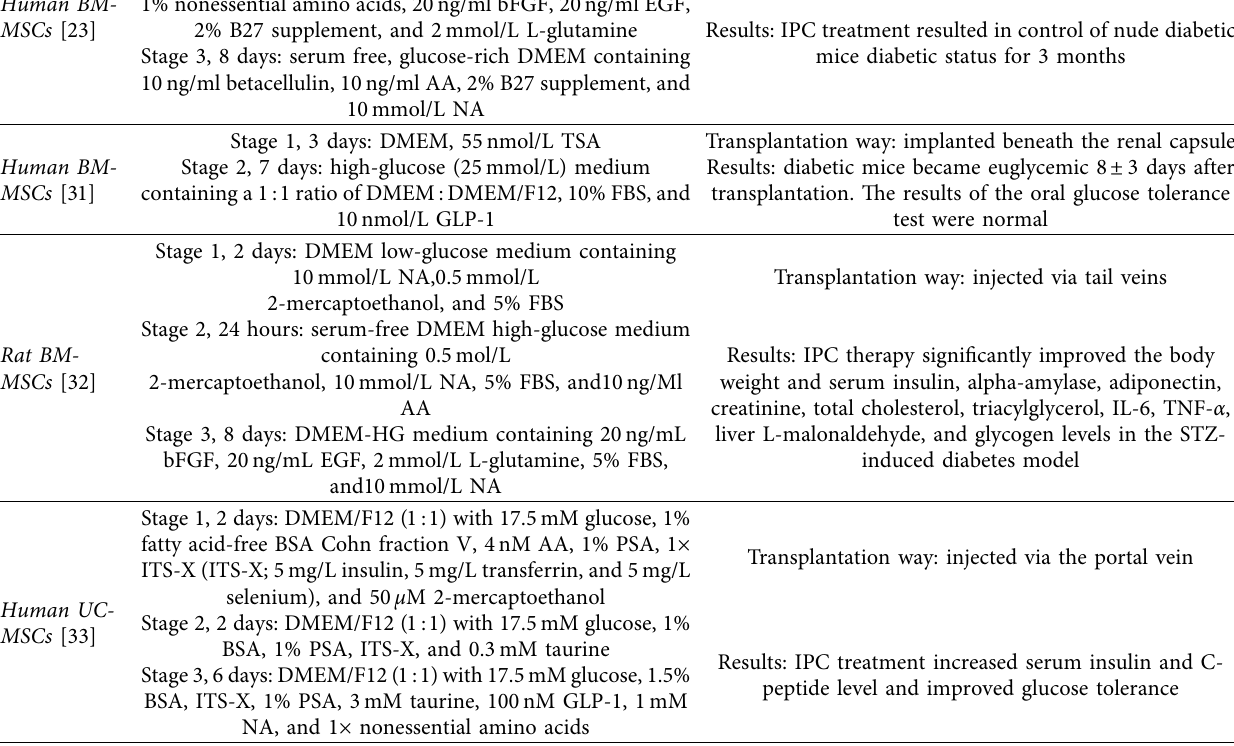
VG:vildagliptin, bFGF:basic fibroblast growth factor, HGF:hepatocyte growth factor, EGF:epidermal growth factor, AA:activin A, NA:nicotinamide, TSA: trichostatin A, DMEM:Dulbecco’s Modified Eagle’s Medium, GLP-1:glucagon-like peptide 1, FBS:fetal bovine serum, ITS:insulin transferrin selenium, and PSA:penicillin/streptomycin/amphoteric